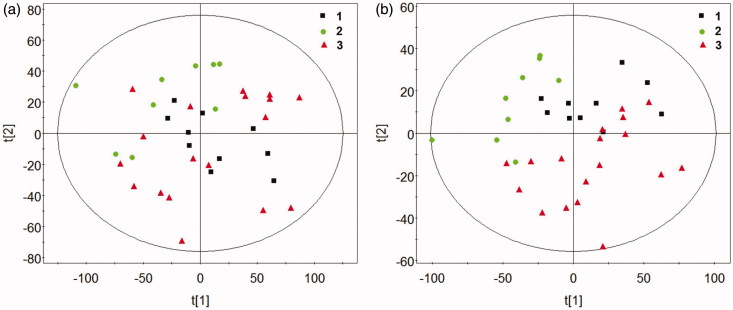
The Scores plot of PCA (a) and PLS-DA (b) by 1HNMR spectra of rat serum (1: Control group, 2: DEN group, 3: DEN + 1,4-GL group).